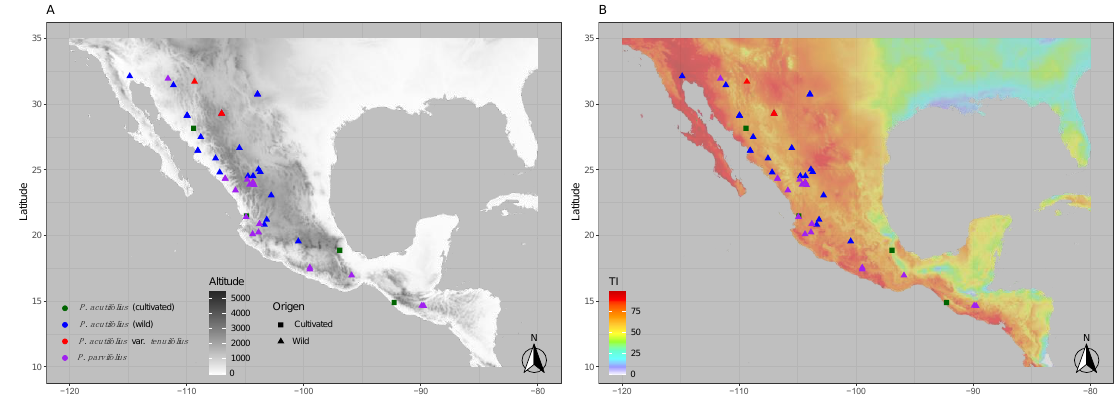
Figure 1. Geographical representation of collection sites for tepary beans s.l. ( P. acutifolius–parvifolius clade) evaluated in this study with ( A ) altitude in meters above sea level as a background and ( B ) drought index on a 30 s grid for the region between the Southern United States and Central America, including the collection hotspot of Northwest Mexico. Dots are colored by taxonomic origin (Table S1) as follows: Green and blue for cultivated and wild P. acutifolius , red for wild P. acutifolius var. tenuifolius , and purple for wild P. parvifolius . Altitudes represented in various tones of achromatic gray. Drought severity index based on Thornthwaite’s potential evapotranspiration (PET) model (DI—Thornthwaite’s index) indicated by scales of red (most intense), orange, yellow to green, and blue (least intense). Latitude and longitude represented by grids in both panels. Wild and cultivated accessions marked as filled triangles ( (cid:78) ) and squares ( (cid:4) ), respectively.